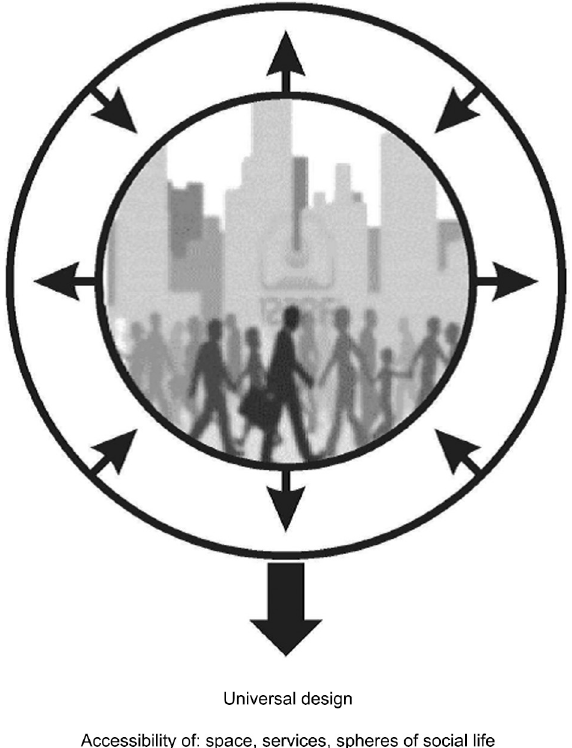
Fig. 1. Geographical model of disability. Arrows symbolise the main directions of